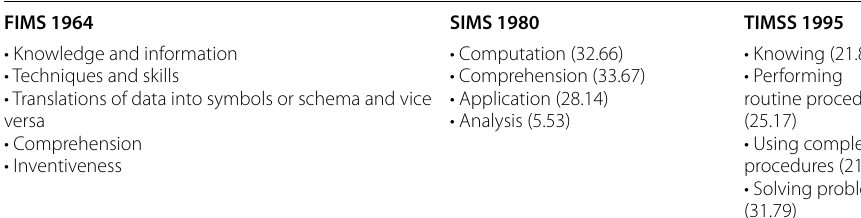
Table 9 Cognitive domains of the mathematics achievement tests